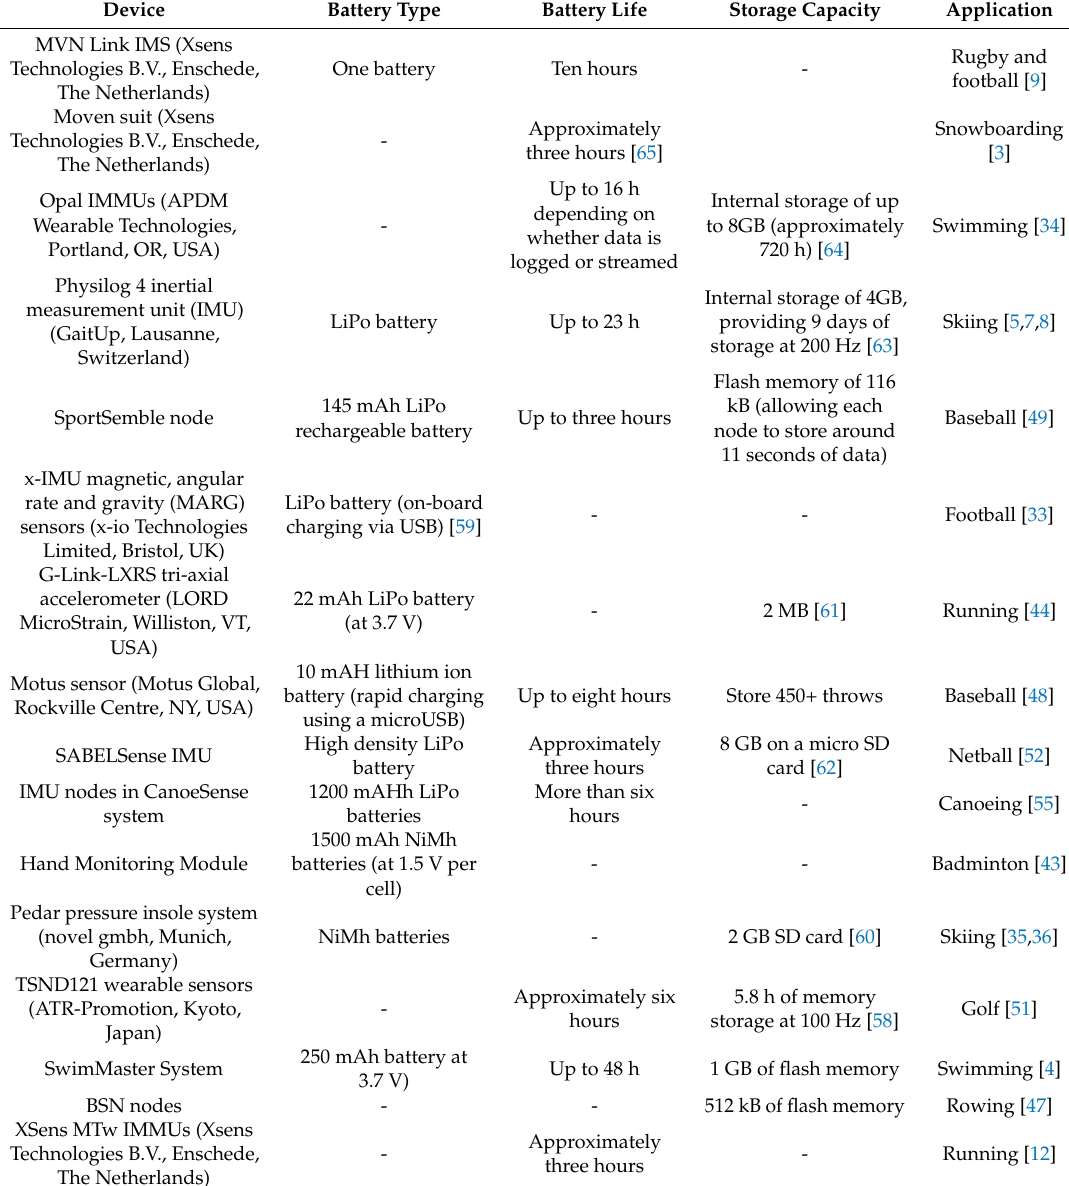
Table 4. Battery and storage features of the wearable device